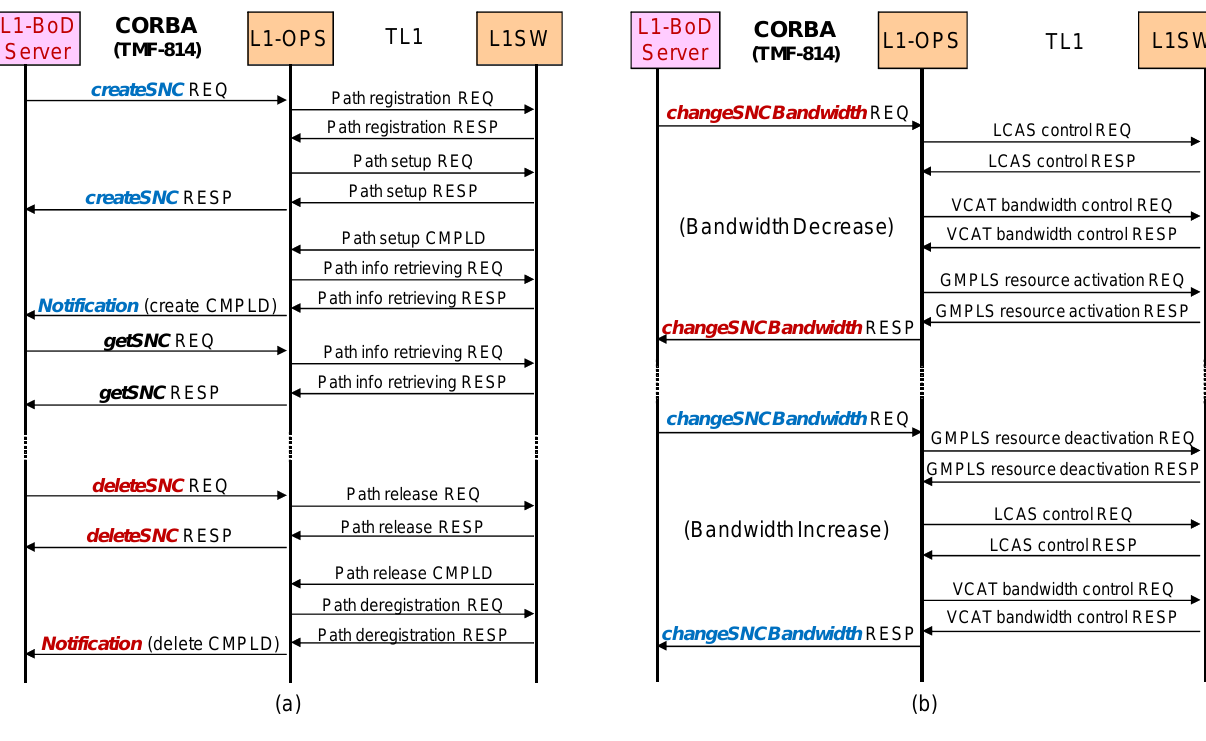
Figure 5. Interface between layer-1 BoD server and L1-OPS. (a) For path setup/release. (b) For path bandwidth